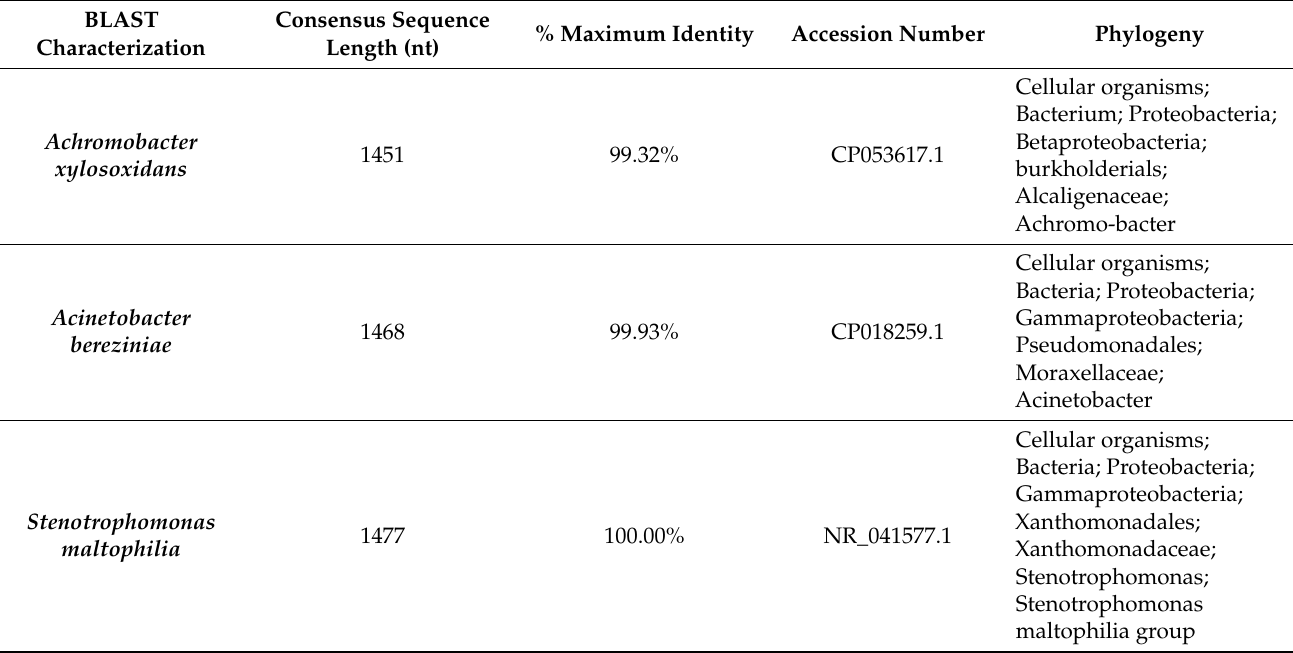
Table 1. BLAST characterization of the rDNA sequence of bacteria isolated from the MFCs anode plate.